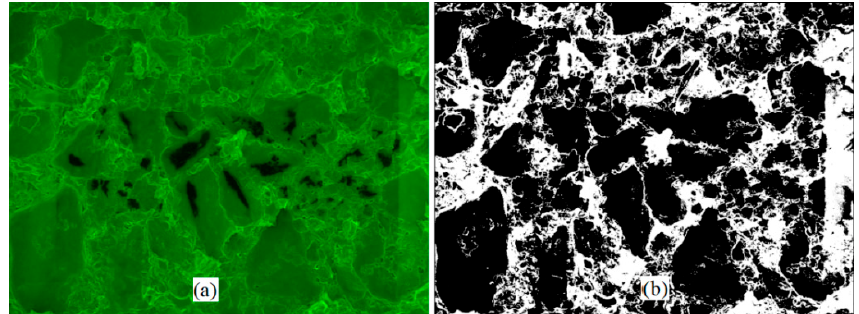
Figure 5. Rubber-wheel contact on the road surface of urethane material under normal load 40.2 N, ( a ) original image; ( b ) binary image based on Otsu thresholding.